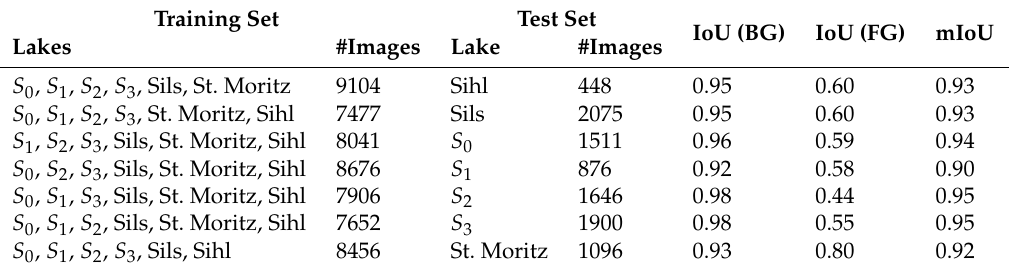
Table 14. Lake detection results (mIoU). The four cameras that monitor lake Silvaplana are indicated as S 0 , S 1 , S 2 , and S 3 . BG and FG denote background and foreground (lake area)